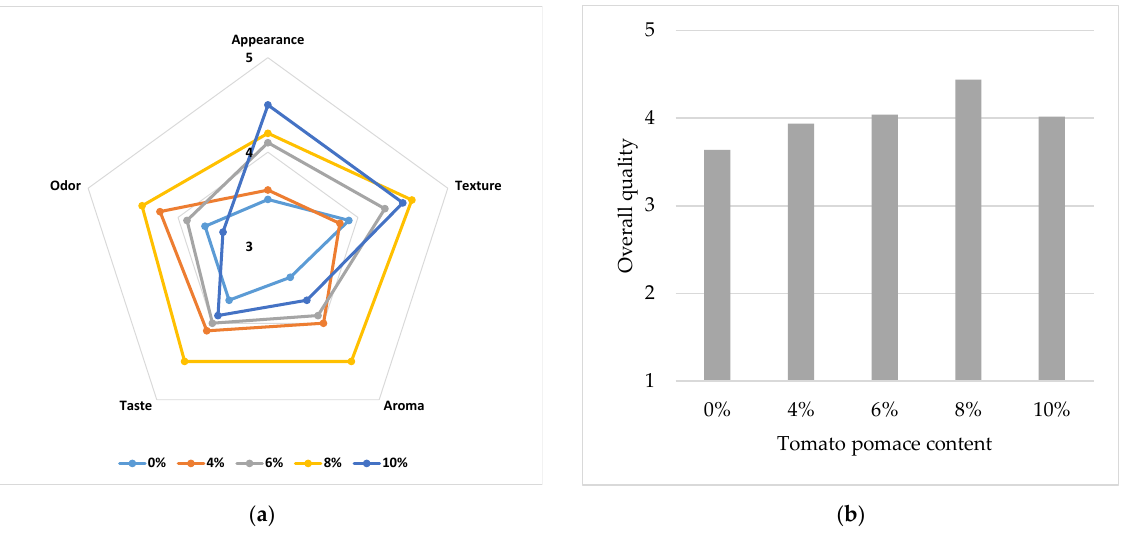
Figure 5. Sensory analysis results ( a ) and overall quality ( b ) of crackers prepared with increasing TP percentages.